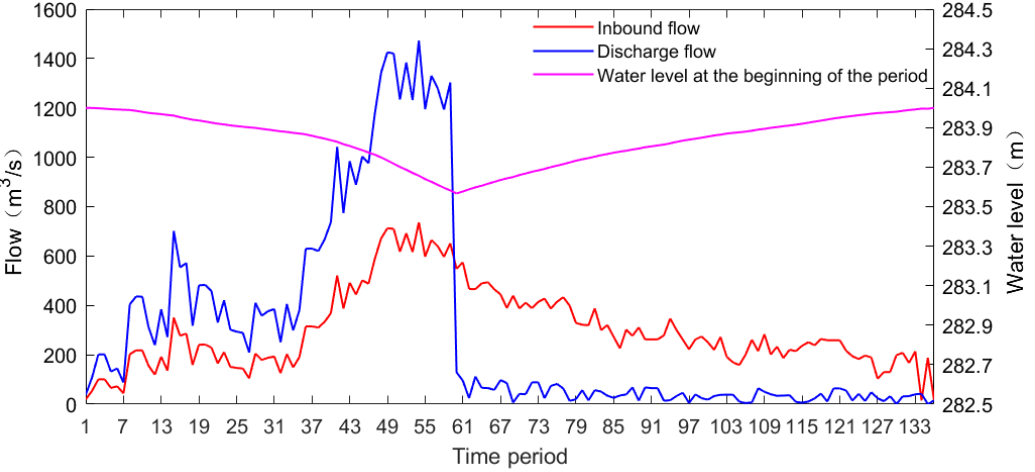
Figure 13. Optimal scheduling results of the first flood with the maximum flood control safety guarantee criterion.